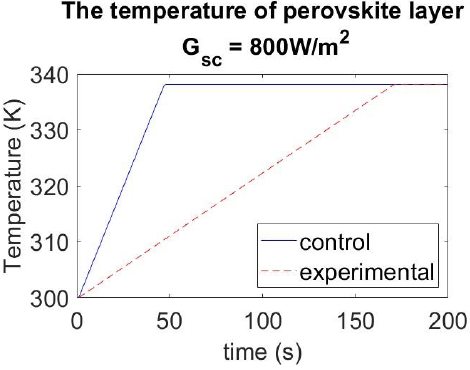
Figure 10. The control and experimental temperature of the perovskite layer in control and experi- mental case under different solar radiation setting. mental case under different solar radiation